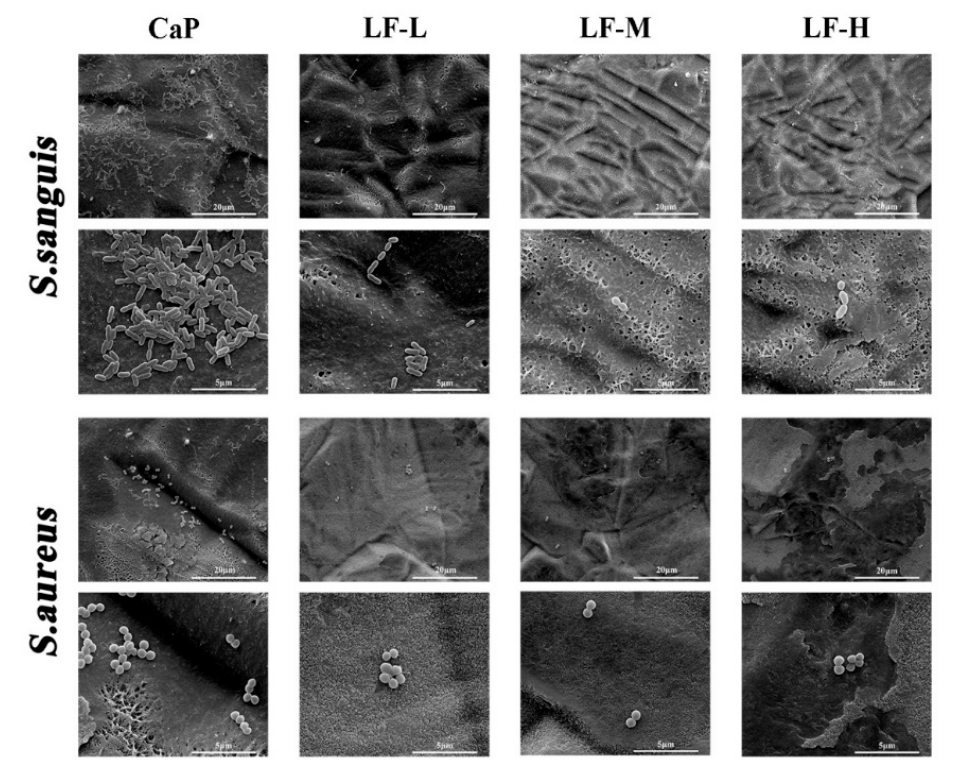
Figure 4. SEM images of adhesive S. sanguis and S. aureus on CaP, LF-L, LF-M, and LF-H samples. The results of the spot assay and bacterial counting are shown in Figure 5. The S. sanguis colonies of the experimental groups were remarkably smaller than those of the CaP group. Compared with CaP, approximately 1Log decrease was recorded for LF-L, and a 2Log decrease to 3Log decrease was record for LF-M and LF-H. The results for S. aureus exhibited a similar